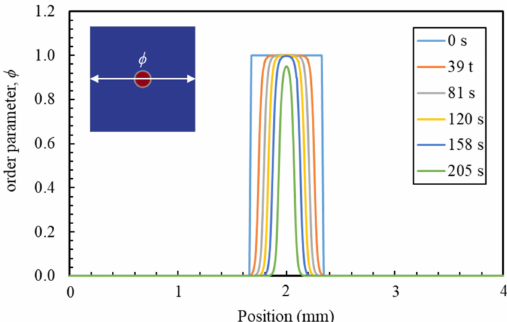
Figure 11. Phase profiles of single NaCl spherical particle along radial direction with time.